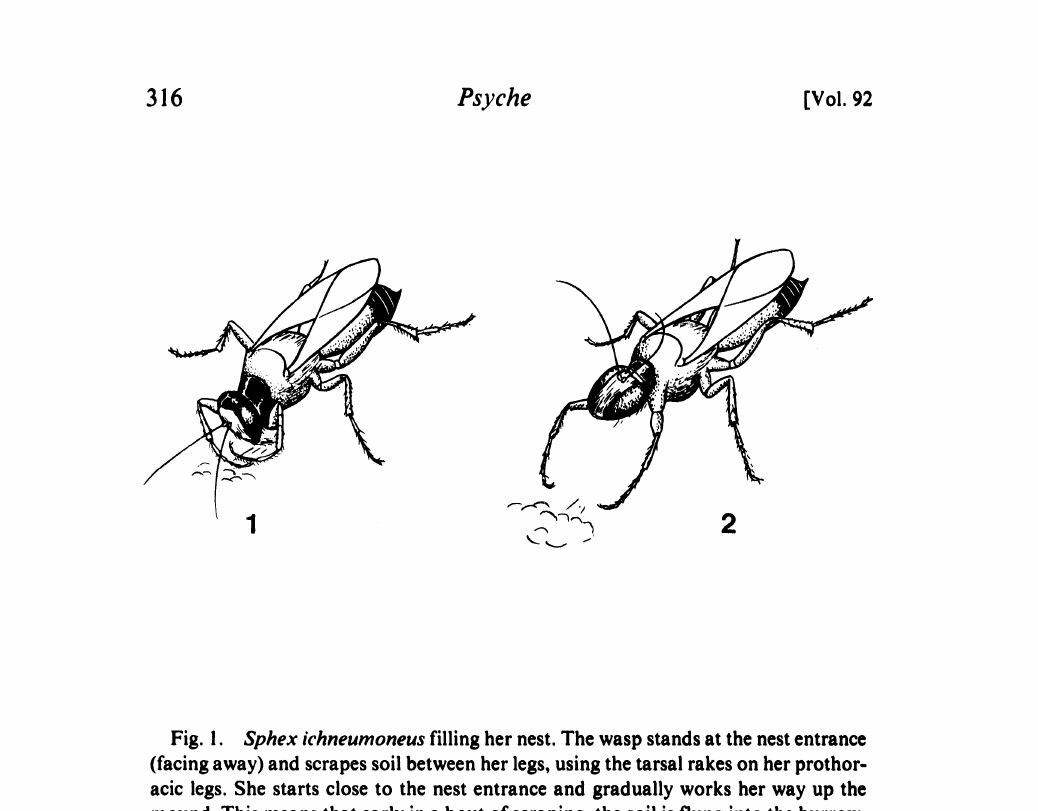
Fig. 1. Sphex ichneumoneus filling her nest. The wasp stands at the nest entrance (facing away) and scrapes soil between her legs, using the tarsal rakes on her prothor- acic legs. She starts close to the nest entrance and gradually works her way up the mound. This means that early in a bout of scraping, the soil is flung into the burrow, whereas later the soil lands close to the nest entrance, and is thrown into the burrow during the next bout of scraping. Scraping is accompanied by frequent biting at the substrate with the mandibles to loosen the soil. The same behavior was observed in Sphex pens ylvanicus. Fig. 2. Sphex ichneumoneus nudges soil into her burrow. After scraping, the wasp turns around and walks down the mound toward her burrow. She often pauses at the nest entrance and nudges at the soil around the lip of the burrow. She pushes the soil ahead of her using the front of the mandibles and clypeus in quick, short, posterior to anterior motions of the head. Similar nudges were observed in $.